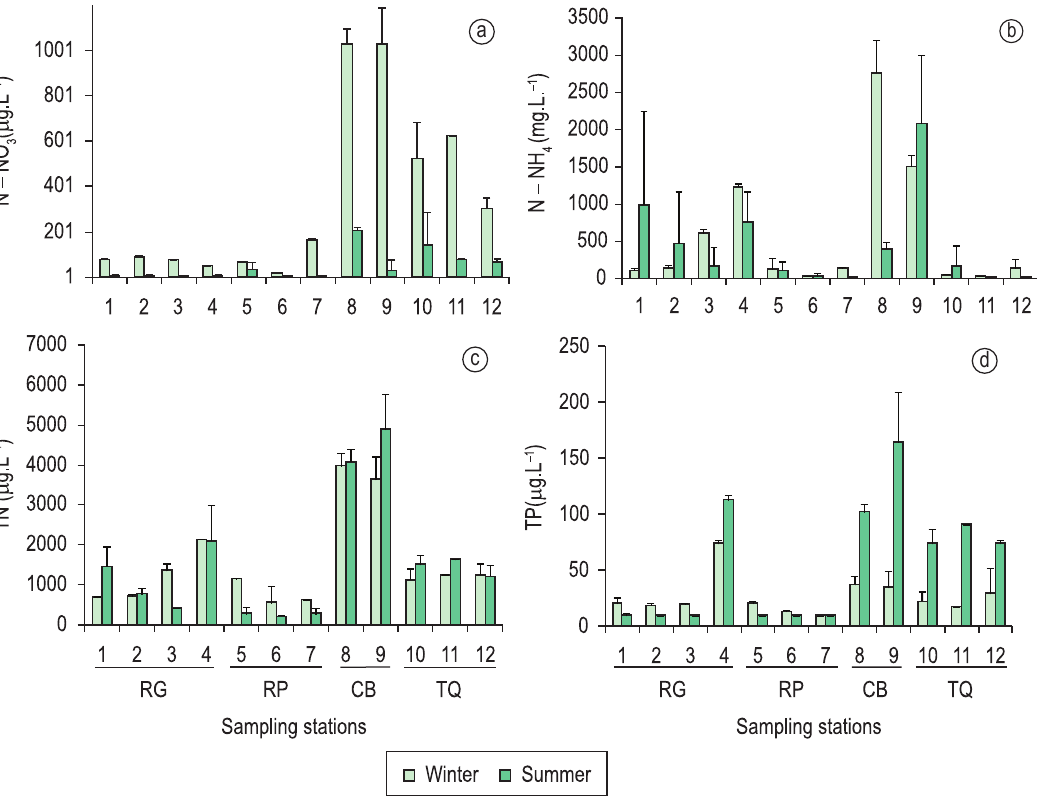
Figure 2. Mean nutrient concentrations for the water profile (and standard deviations) for the Billings Complex dur- ing winter and summer periods. Sampling sites: RG: Rio Grande Reservoir, RP: Rio Pequeno branch, CB: Central body, TQ: Taquacetuba branch: a) nitrate, b) ammonium, c) total nitrogen, d) total